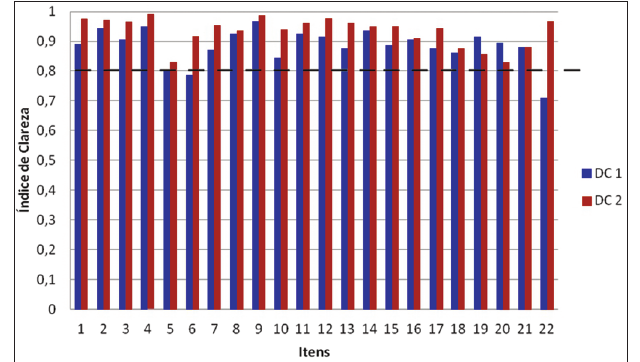
Figura 1. Determinação de Clareza do SNOT-22. Mostra o índice de clareza de cada item do “SNOT-22”. As barras em cor azul representam o índice de clareza no primeiro desdobramento cognitivo e as barras em cor vermelha o índice de clareza no segundo desdobramento cognitivo. A linha tracejada mostra o ponto de corte de 0.80 a partir do qual o item é considerado claro. Observa-se que os itens 6 e 22 situaram-se abaixo do índice de clareza na primeira etapa de desdobra - mento e que todos os itens do “SNOT-22” foram considerados claros no segundo desdobramento cognitivo. DC: desdobramento